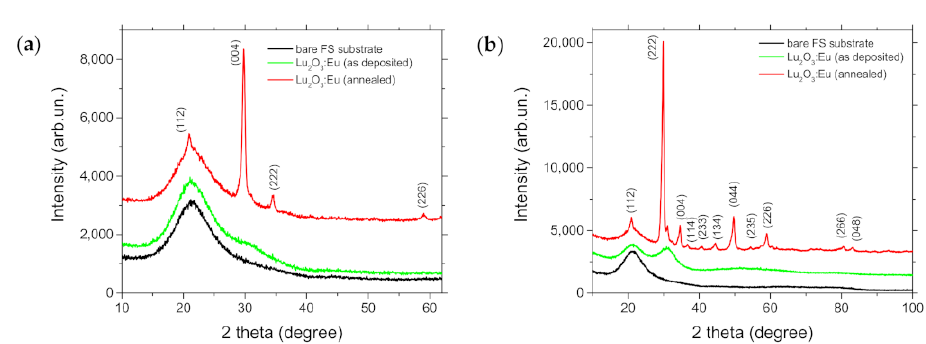
Figure 13. XRD patterns of Lu 2 O 3 :Eu thin film (as deposited and after PLA processing, seven shots), ( a ) 2theta-omega and ( b ) grazing incidence